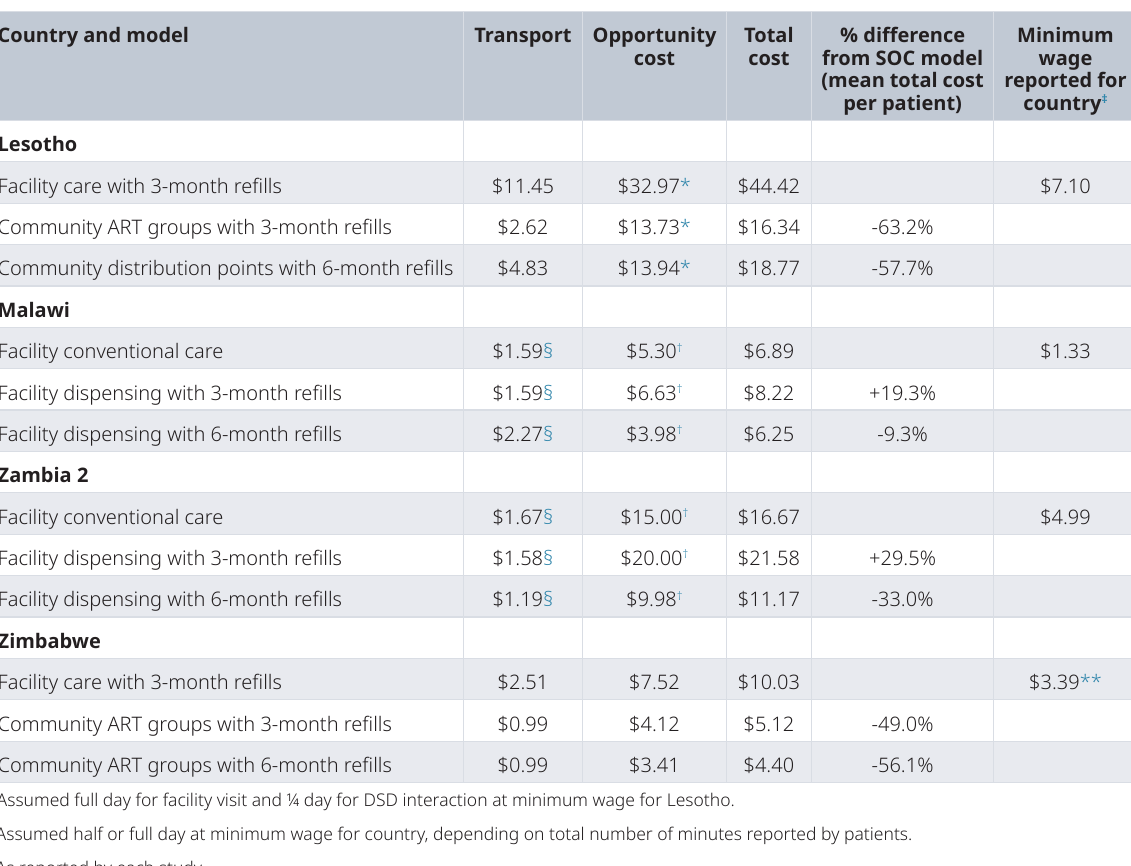
Table 6. Average costs to patients per year in care, by